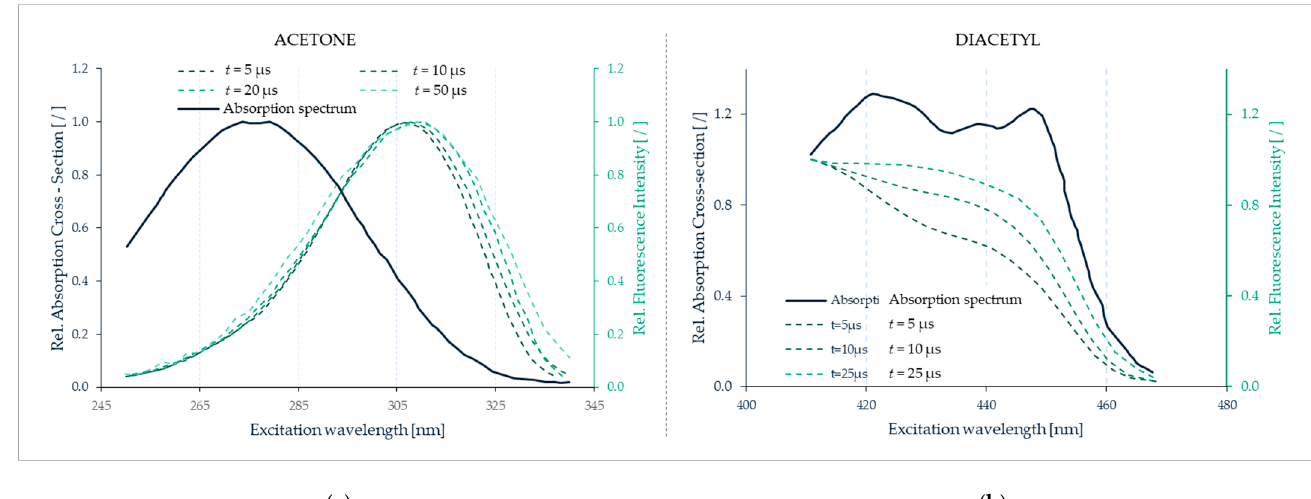
Figure 33. Absorption (solid black lines) of ( a ) acetone, obtained by Lozano et al. [171], and ( b ) of diacetyl, obtained by Stier and Koochesfahani [176] and phosphorescence emission (dashed green lines) intensity of ( a ) acetone, and ( b ) diacetyl, as a function of the laser excitation wavelength, obtained by Fratantonio et al. [172]. The signals are normalized by the intensity value for the wavelength of peak emission. ( a ) Acetone vapor at p = 15 kPa and T = 293 K; ( b ) Diacetyl vapor at p = 5 kPa and T = 293 K. Data from